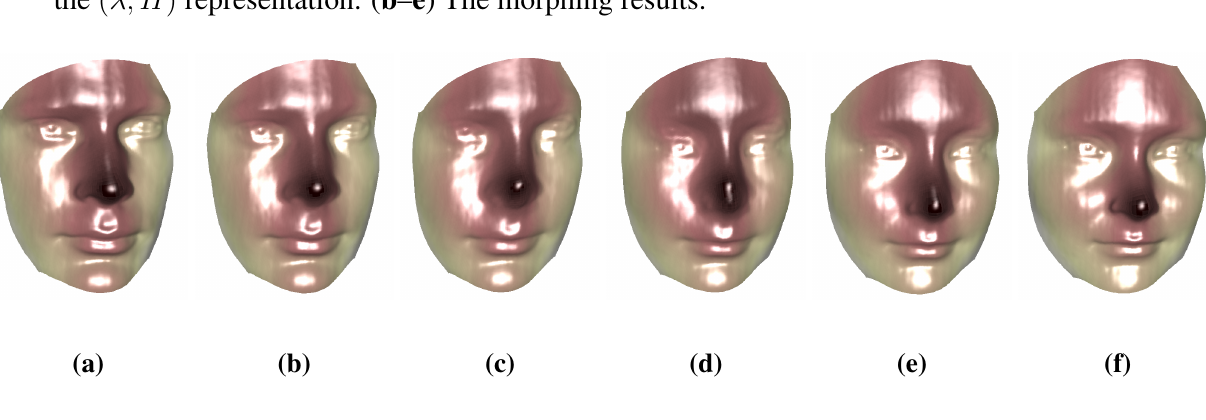
Figure 9. Surface morphing between two human faces (from a male face to a female face) using the ( λ, H ) representations. ( a , f ) A male and a female face, respectively. By using the morphing algorithm, we interpolate λ and H and reconstruct the corresponding surface from the ( λ, H ) representation. ( b – e ) The morphing